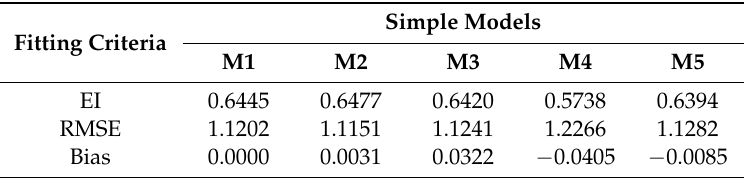
Table 3. Fitting statistics of the simple models